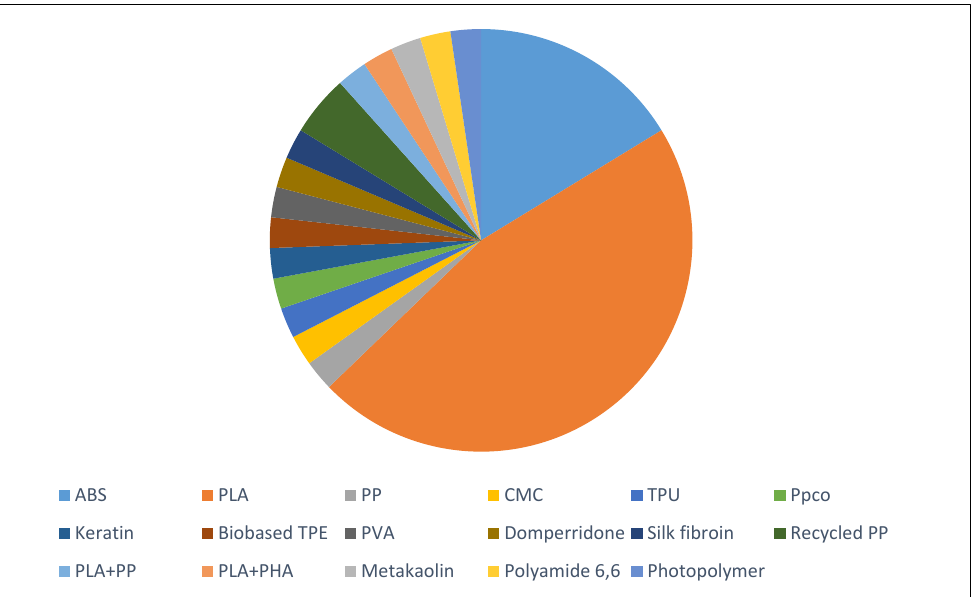
Figure 1. Different polymers used in reviewed studies. Figure 1. Di ff erent polymers used in reviewed